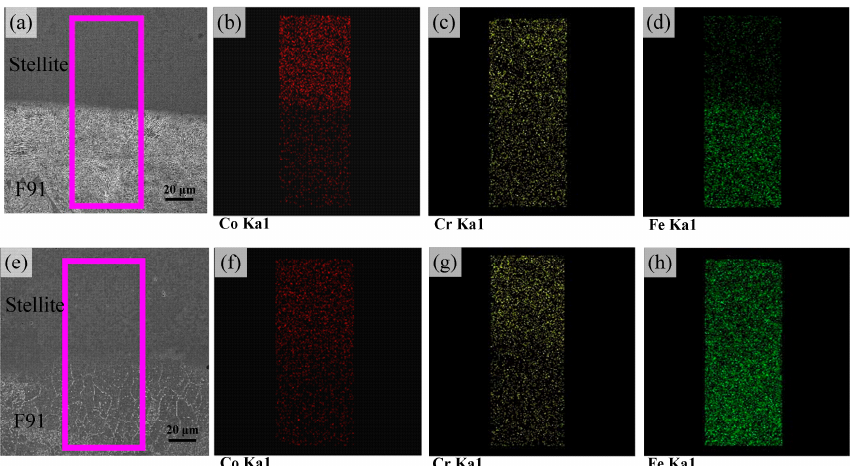
Figure 5. The alloying elements distribution around the Stellite-steel boundary of samples ( a – d ) #1 and ( e – h ) #2.